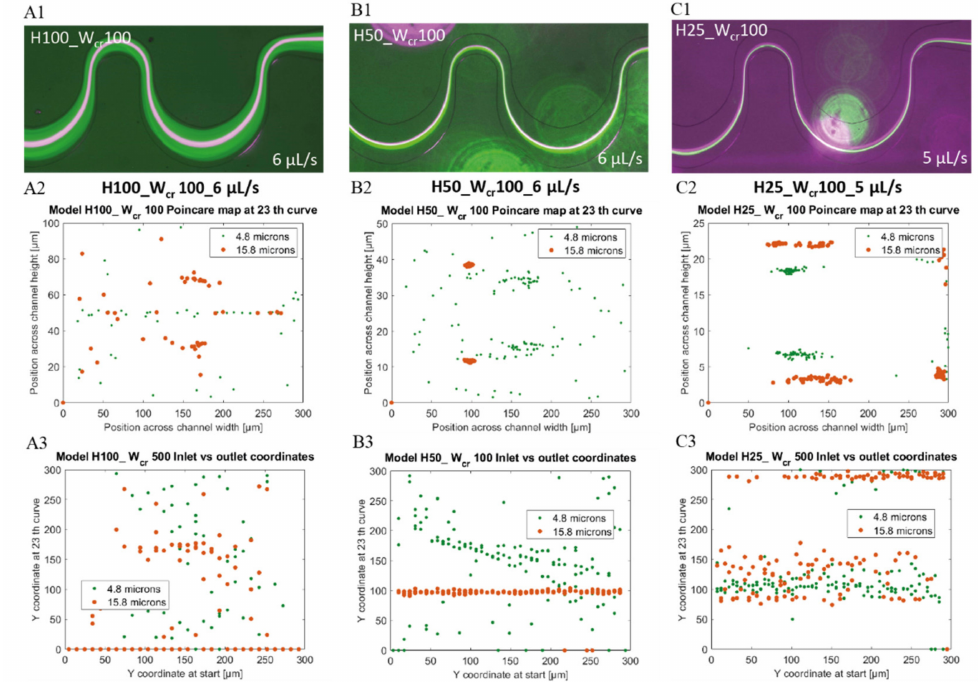
Figure 8. Position of 4.8 µ m (green) and 15.8 µ m (purple and orange) beads in microfluidic channels having 100 µ m critical width and different channel heights of 100–50–25 µ m at high flow rates (6 µ L/s and 5 µ L/s). Experimental data ( A1 , B1 , C1 ) with 4.8 µ m (green) and 15.8 µ m (purple) beads— top view. Computational data of bead’s lateral distribution (Poincare map) at the end of the channel —cross sectional view ( A2 , B2 , C2 ); and beads’ focusing tendency through the channel as y coordinates at the outlet vs. initial y coordinates ( A3 , B3 , C3